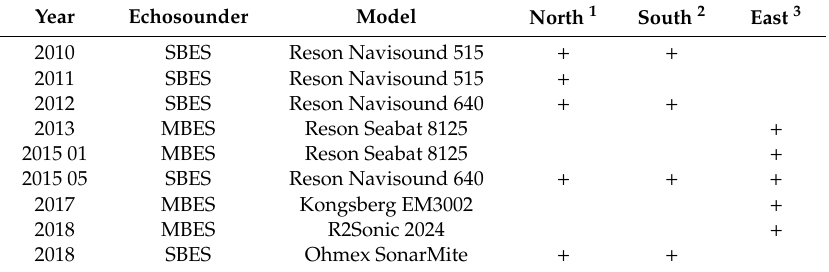
Table 1. Measurements in the pier area in Sopot and the bathymetric equipment